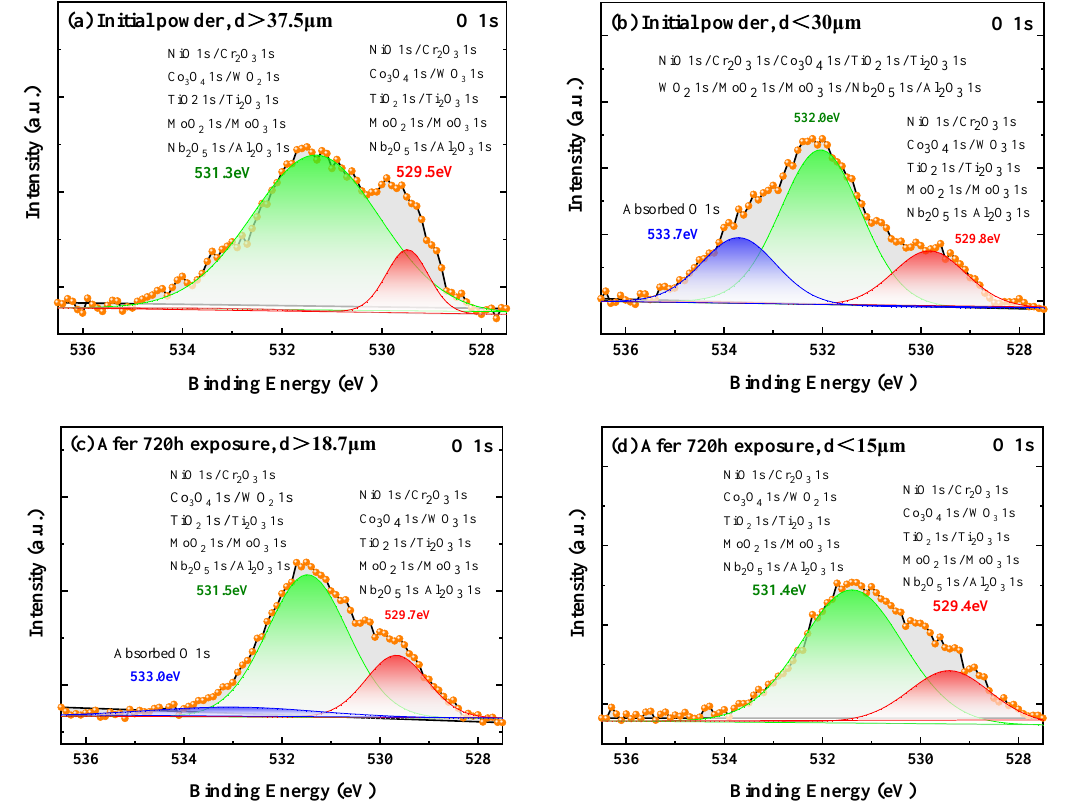
Figure 6. Surface oxidation states of initial powders with particle sizes of ( a ) above 37.5 μm; ( b ) below 30 μm, and of the powders after 720 h exposure with particle size of ( c ) above 18.7 μm; ( d ) below 15 μm.